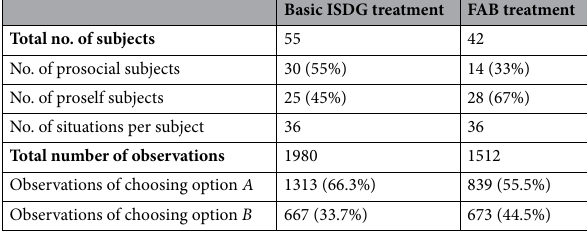
Table 1. Summery